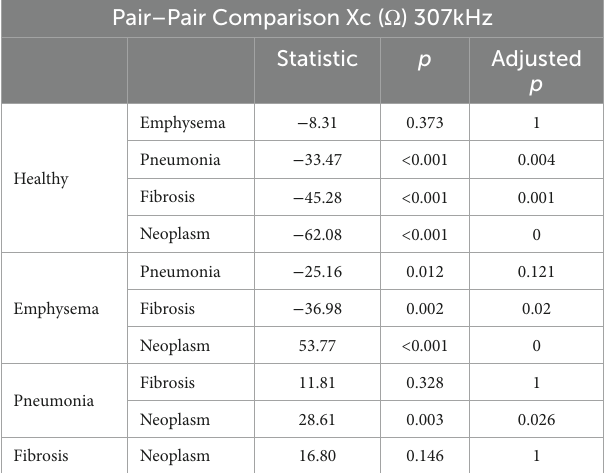
TABLE 3 Pair to pair comparisons for Xc bioimpedance parameter with significance adjusted by Bonferroni